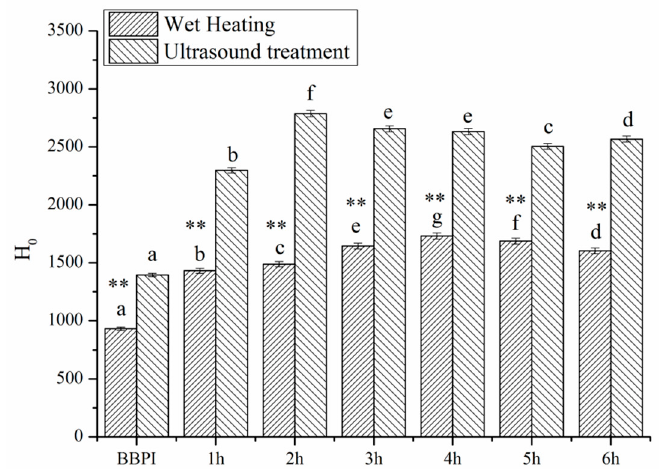
Figure 3. Surface hydrophobicity ( H 0 ) of BBPI by wet heating and ultrasound treatment Maillard reaction obtained for 1–6 h, respectively. Means with dissimilar lower-case letters indicate significant di ff erences ( p < 0.05), ** means in the same time p < 0.01, * means in the same time p <